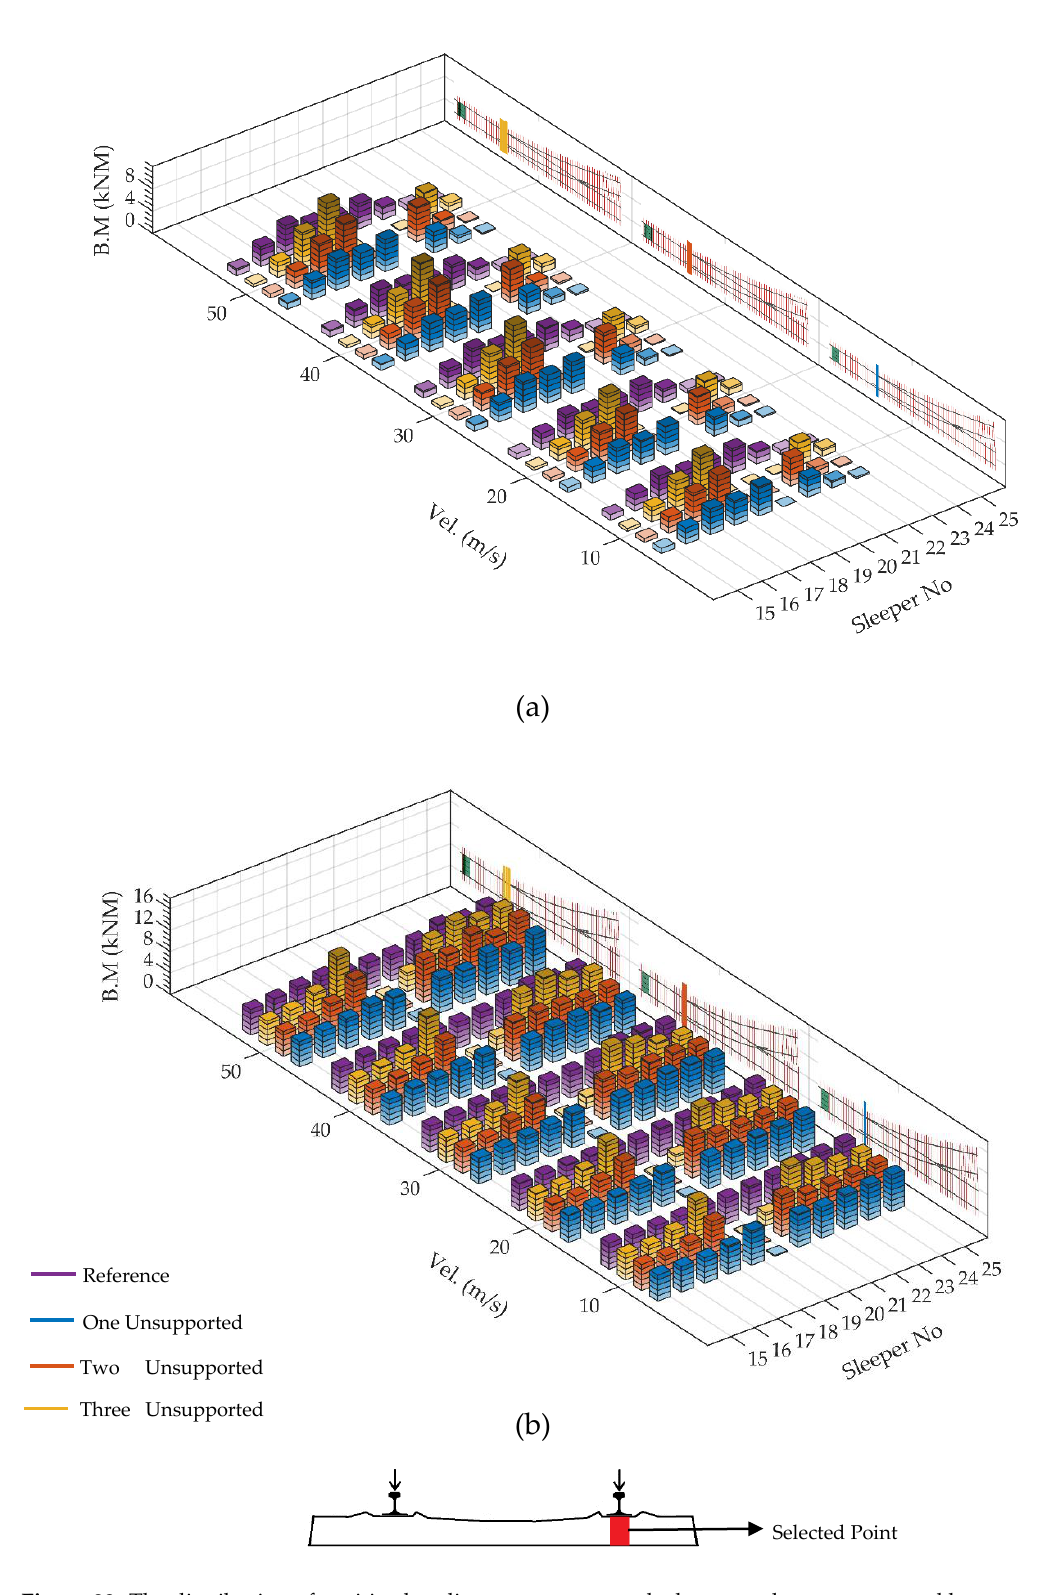
Figure 23. The distribution of positive bending moments over the bearers when unsupported bearers exist under switchblades: ( a ) at particular time when the front wheel is on the bearer with number 20; ( b ) when maximum occurs at each bearer.